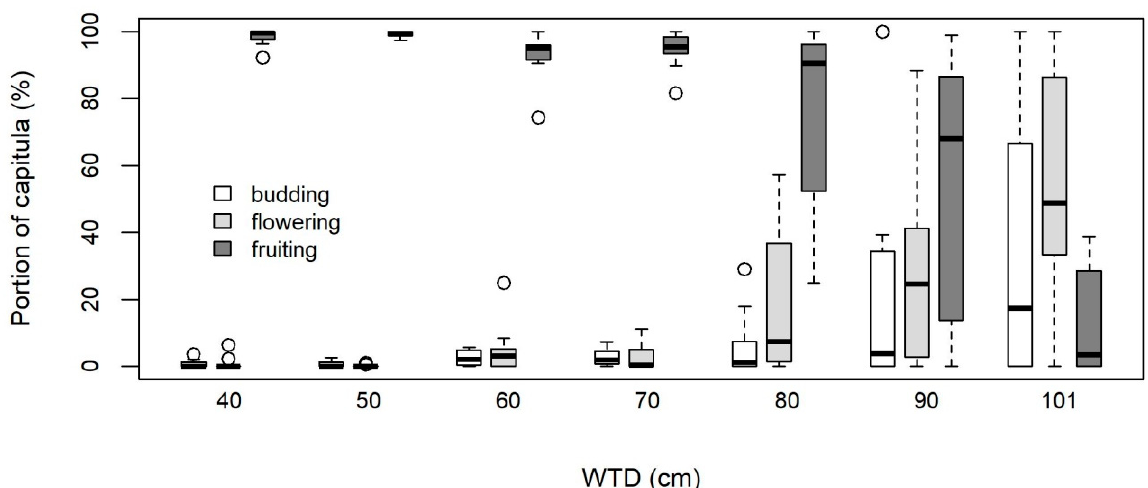
Figure 8. Portion of budding, flowering and fruiting capitula per plant of cup plant depending on water table distance (WTD, given as mean for each row of the four tanks). Data were collected at the end of the second growing season (September 2019). Note that the three different phenological stages of a treatment are always shown next to each other with a slight offset. n = 12 (in 90 cm WTD n = 11; in 101 cm WTD n = 10, because these three plants did not develop any capitulum at that time).